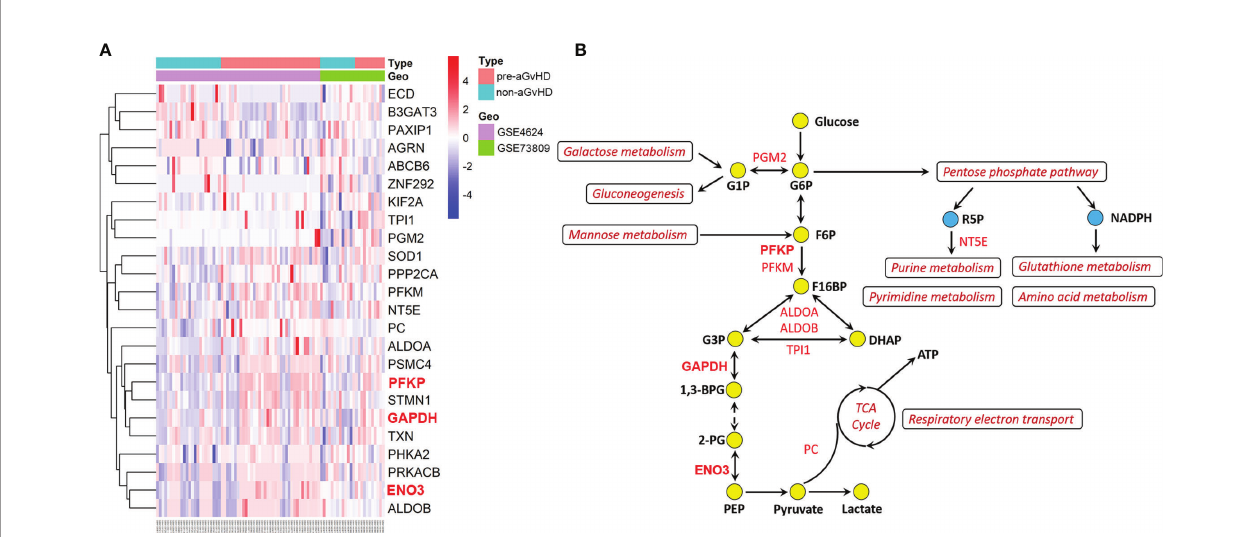
FIGURE 2 | Dysregulation of glycolytic genes and glycolysis-associated metabolic pathways. (A) Heatmap and hierarchical clustering of differentially expressed glycolytic genes. The right longitudinal axis indicates names of differentially expressed genes. The left longitudinal axis represents clustering information. The red color represents the upregulated genes; the blue color represents the downregulated genes; the white color represents genes without change. Signi fi cance was de fi ned in Figure 1A , above. (B) Schematic overview of upregulated glycolytic genes and activated glycolysis-associated metabolic pathways. Red text indicates upregulated genes, and dark red text indicates activated pathways. The yellow circles represent glycolytic metabolites, and the blue represents metabolites of pentose phosphate pathway. G1P, glucose-1-phosphate; G6P, glucose-6-phosphate; F6P, fructose 6-phosphate; F16BP, fructose 1,6-bisphosphate; G3P, glyceraldehyde 3- phosphate; DHAP, dihydroxyacetone phosphate; 1,3-BPG, 1,3-bisphosphoglycerate; 2-PG, 2-phosphoglycerate; PEP, phosphoenolpyruvate; TCA, tricarboxylic acid; ATP, adenosine triphosphate; R5P, ribose 5-phosphate; NADPH, nicotinamide adenine dinucleotide